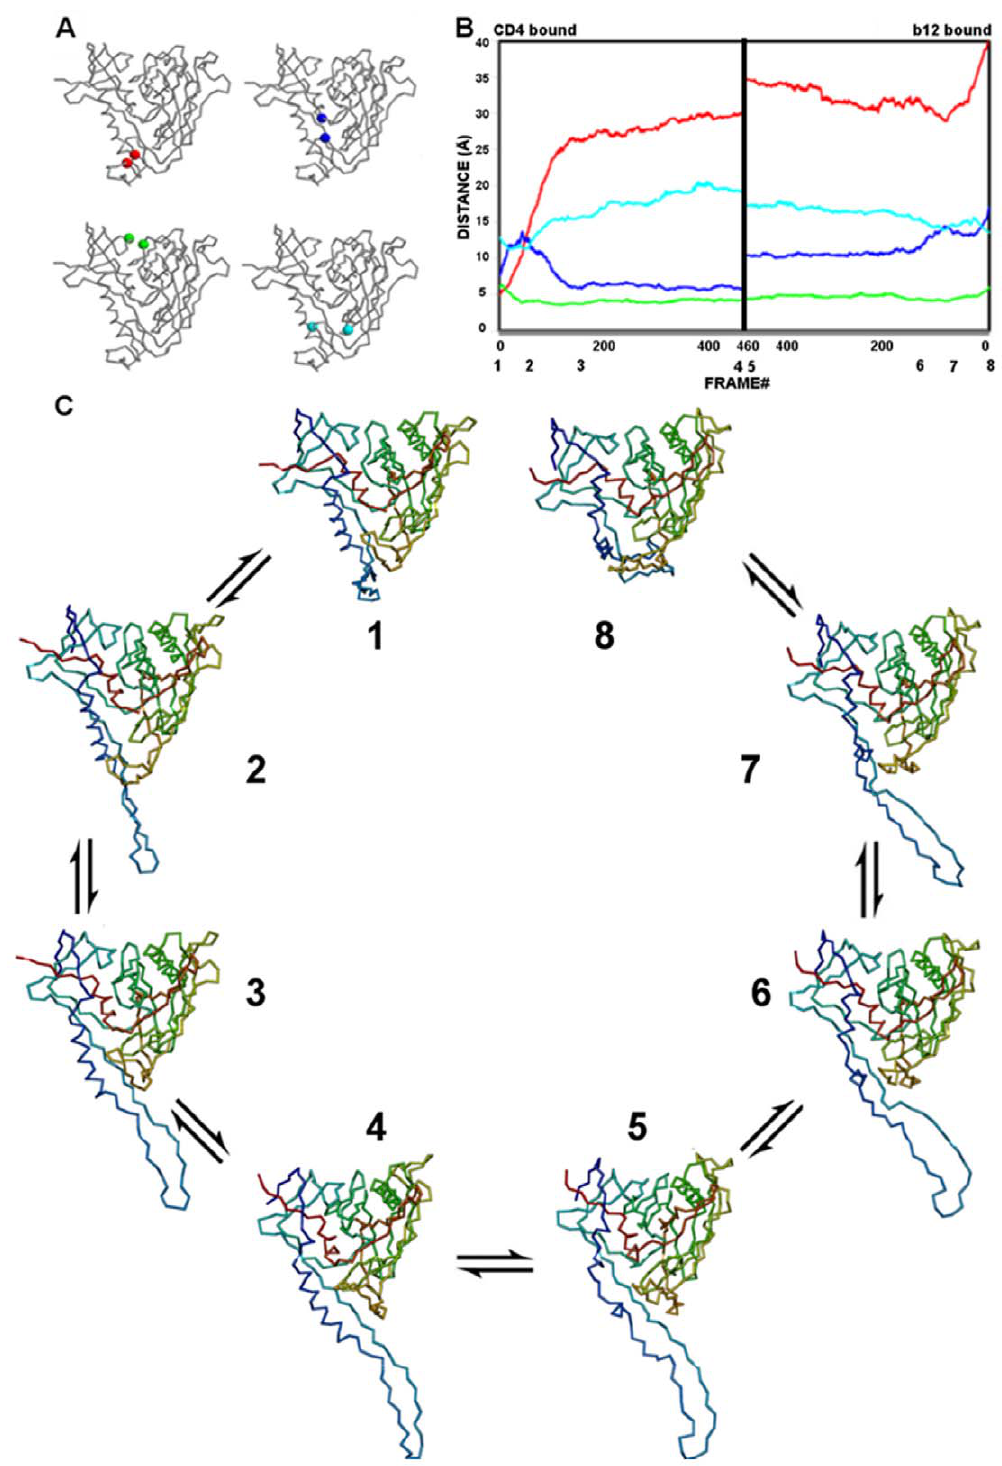
Figure 11. The gp120 transition pathway between CD4- and b12-bound states. ( A ) Monitor cues mapped onto C a -backbone drawings of gp120 in the CD4-bound state. Stability of the bridging sheet is monitored by the distance between Thr123 and Gly431 (red); opening of the vestibule of the Phe43 cavity is monitored by the distance between Trp427 and Met475 (blue); the inner/outer domain cleft is monitored by the distance between Lys231 and Glu267 (green); and the integrity of the Phe43 cavity is monitored by the distance between Trp112 and Phe382 (cyan). ( B ) The progression of monitor distances, colored as in A , during the gp120 trajectory. Numbers below the x-axis mark the positions of structures visualized in panel C . ( C ) The identified gp120 transition intermediates along the trajectory starting from the CD4-bound state (1) and ending at the b12-bound state (8). Structures are drawn as C a backbones colored spectrally from N (blue) to C (red).